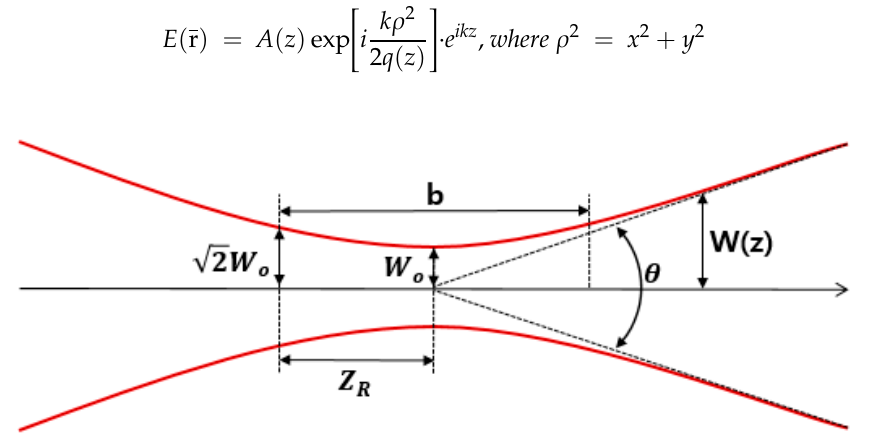
Figure 13. Gaussian beam propagation factor.